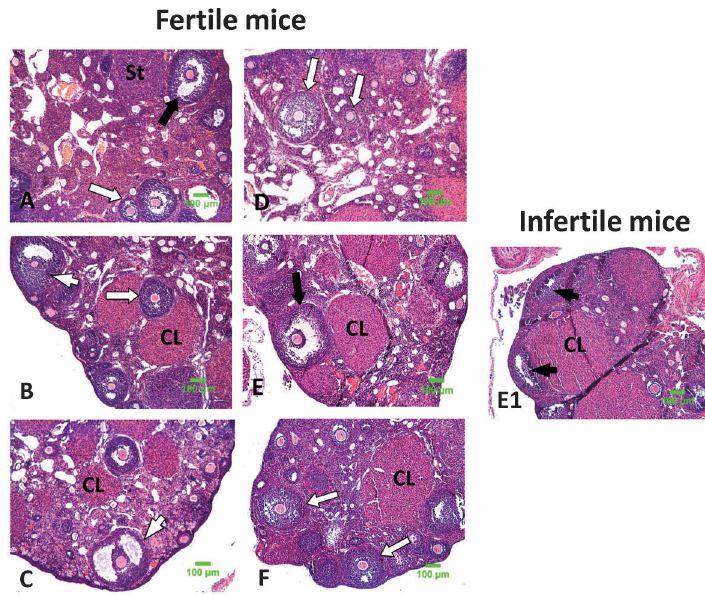
Figure 8. Histological examination of ovarian sections of the ICR mice immunized intranasally with different chitosan-DNA nanoparticles. Ovaries were collected from fertile and infertile mice (n=6/group) on day 49 after final immuni- zation. Ovarian sections were stained with hematoxylin and eosin and photographs (100X) were taken under a microscope. Ovaries were collected from naive mice ( A ) or mice immunized with chitosan ( B ), chi-pcDNA3 ( C ), chi-pcD- Lzp3 ( D ), chi-(pcD- Lzp3 +pcD- mIL-33 ) ( E , E1 ) and chi-pcD- mIL-33 ( F ). Black arrows indicate nor- mal mature ovarian follicles; white arrows indi- cate immature ovarian follicles; white arrowheads indicate tertiary follicles; black arrowheads indicate atrophic follicles; CL: cor- pora lutea; St: